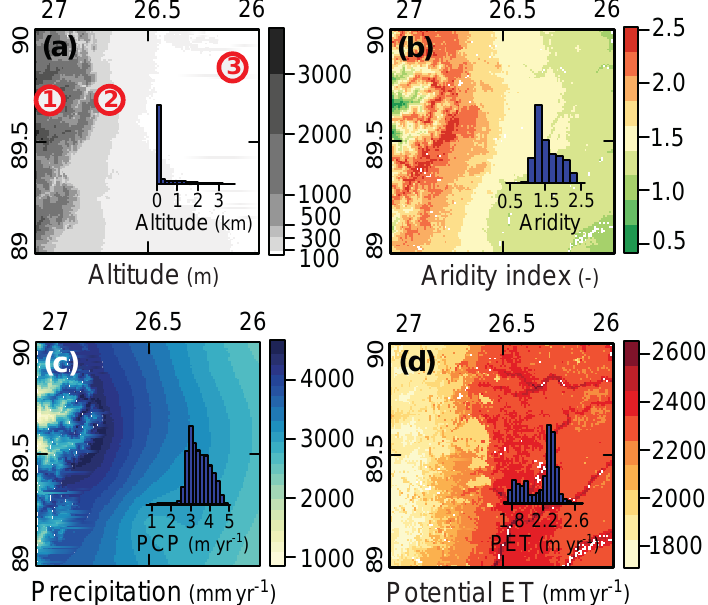
Figure 10. Spatial patterns of altitude, precipitation ( P ), potential evapotranspiration (PET), and aridity index ( P /PET) in 1 ◦ by 1 ◦ grid cell in the Himalayas at 89–90 ◦ E, 26–27 ◦ N. There is a sharp gradient in P , PET, and altitude in this grid cell. The labeled points 1, 2, and 3 correspond to the labeled points in Fig. 11.